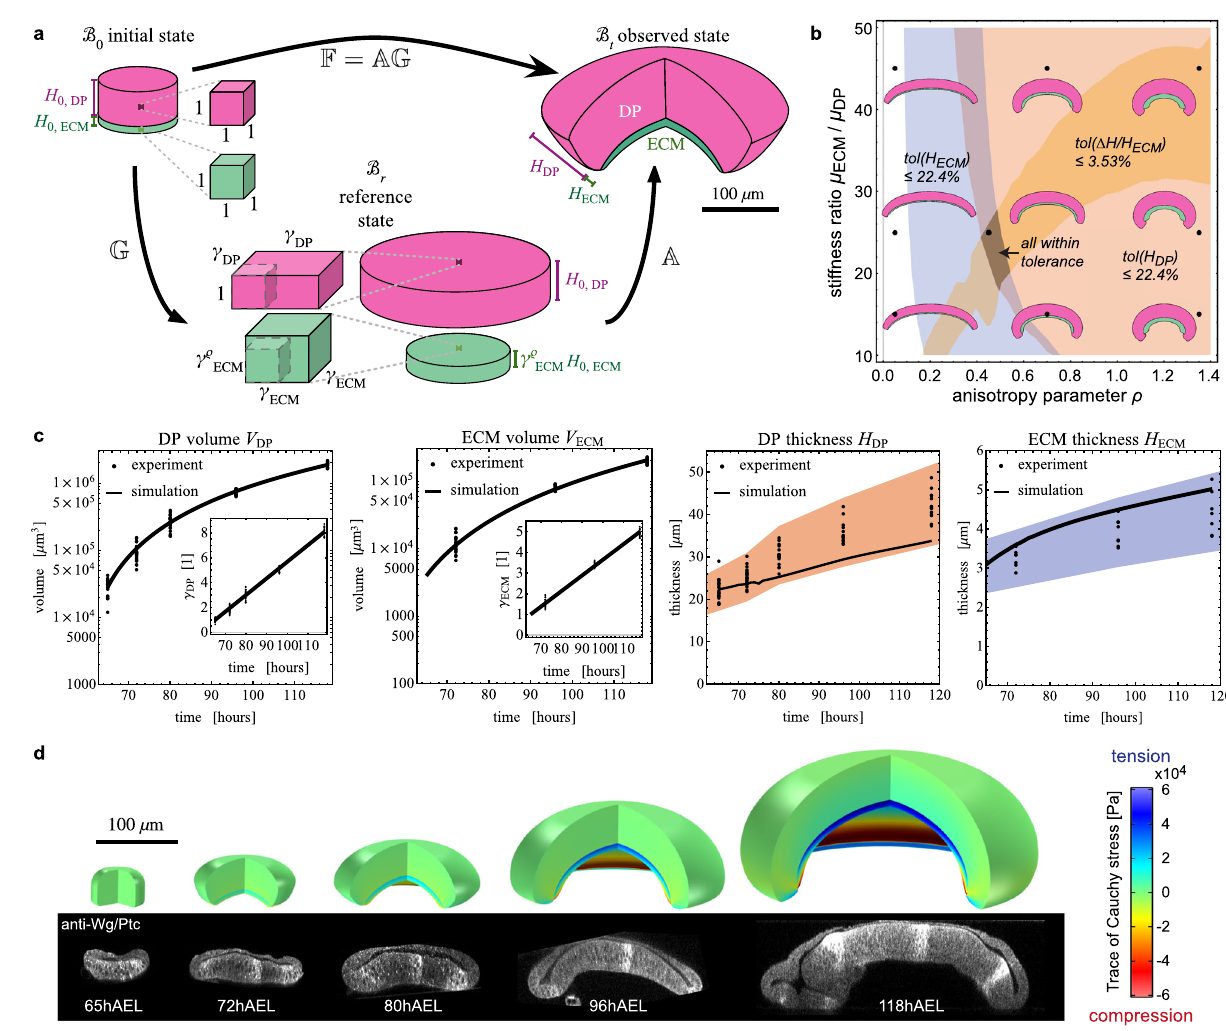
Fig. 5 | An elastic bilayer model captures growth-induced epithelial morpho- genesis. a Geometric decomposition for a bilayer structure, composed of DP (purple) and ECM DP (green). In the initial state B 0 , the disc is unstressed and undeformed. Representative volume elements with unit lateral lengths are shown. The DP and ECM thickness is denoted H 0, DP and H 0, ECM , respectively. The growth tensor G describesthetransformationtothereferencestate ℬ r whichisgrownand